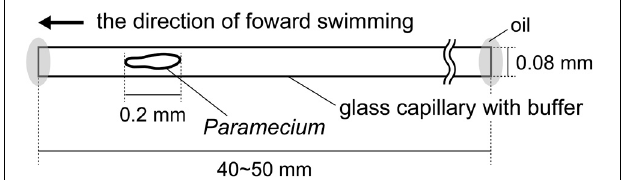
FIGURE 2 | Typical behavior of Paramecium in a dead-ended capillary. (A) Time-course of distance from capillary end. (B) Distribution of backward swimming